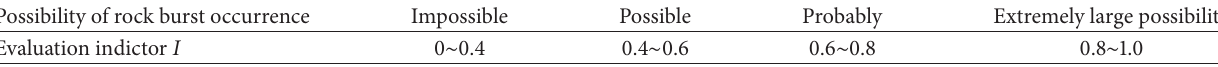
Table 2: The possibility of evaluation index of the rock burst occurrence evaluated by the drill pipe torque method. Possibility of rock burst